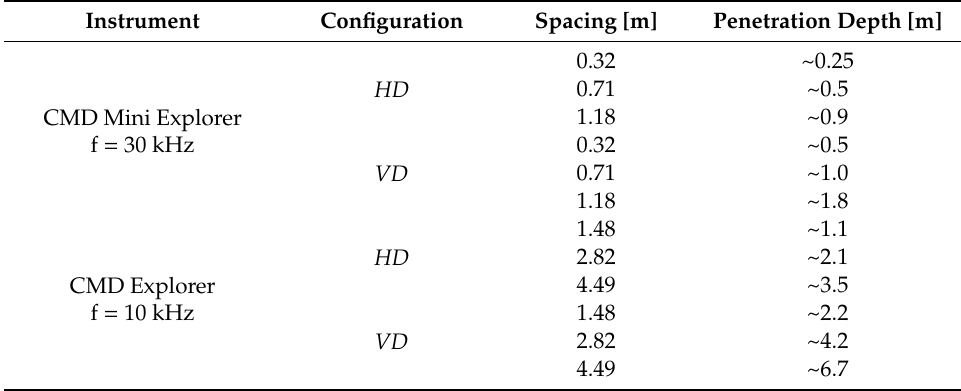
Table 3. Spacings and penetration depths for CMD Mini Explorer and CMD Explorer for di ff erent configurations [20]. Instrument Configuration Spacing [m] Penetration Depth